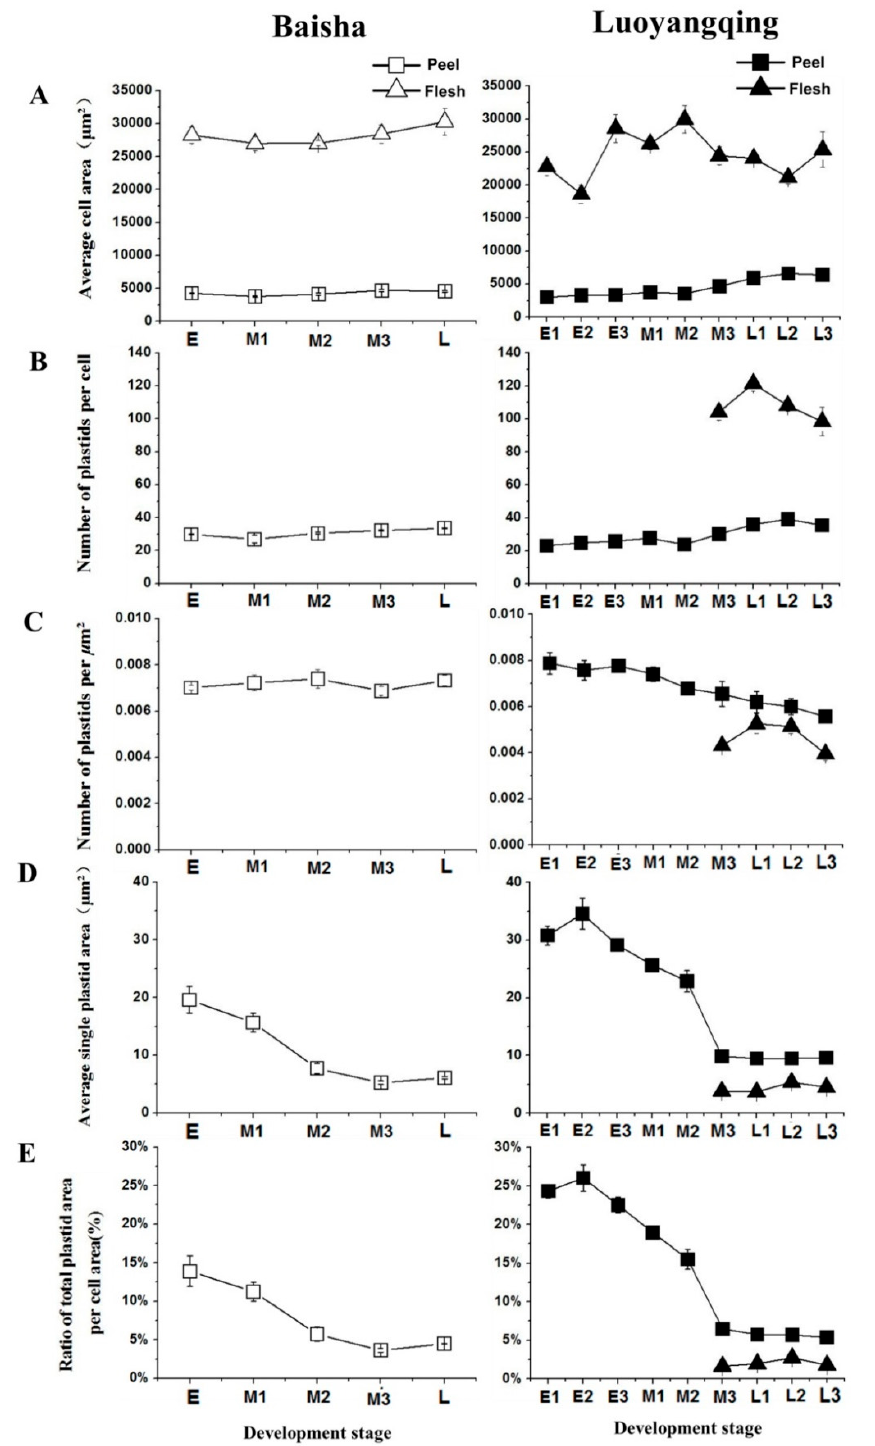
Figure 4. Changes in cell size and plastid number and size during the ripening of Luoyangqing and Baisha loquat fruits. ( A ) Cell size indicated by area; ( B ) plastid population; ( C ) plastid density; ( D ) plastid size indicated by area; ( E ) plastid size (by area) relative to cell size (by area). During fruit ripening, not only the type and the number of plastids changed, but the size did as well. Both the average single plastid area and the proportion of total plastid area per cell area declined by around two-thirds for the plastids in peel cells of both cultivars, while no obvious decline